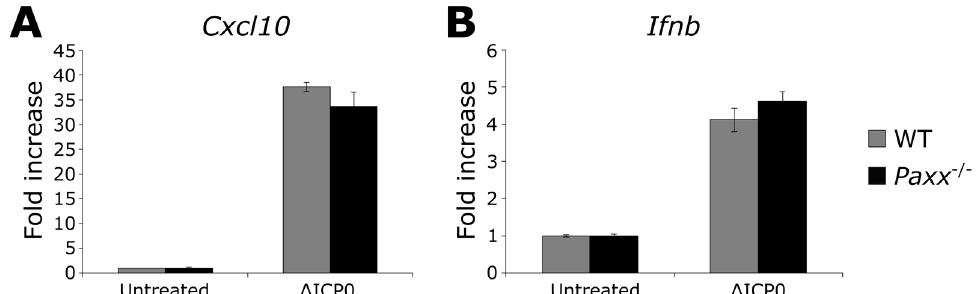
Figure 3. PAXX does not affect innate immune responses to HSV-1 ∆ ICP0 infection. WT or Paxx − / − Mouse embryo fibroblasts (MEFs) were infected with MOI 5 ∆ ICP0 for 5 hr, and qPCR was used to analyse the transcription of ( A ) Cxcl10 ; and ( B ) Ifnb. n = 3. Error bars denote mean +/ − standard error of the mean (SEM).